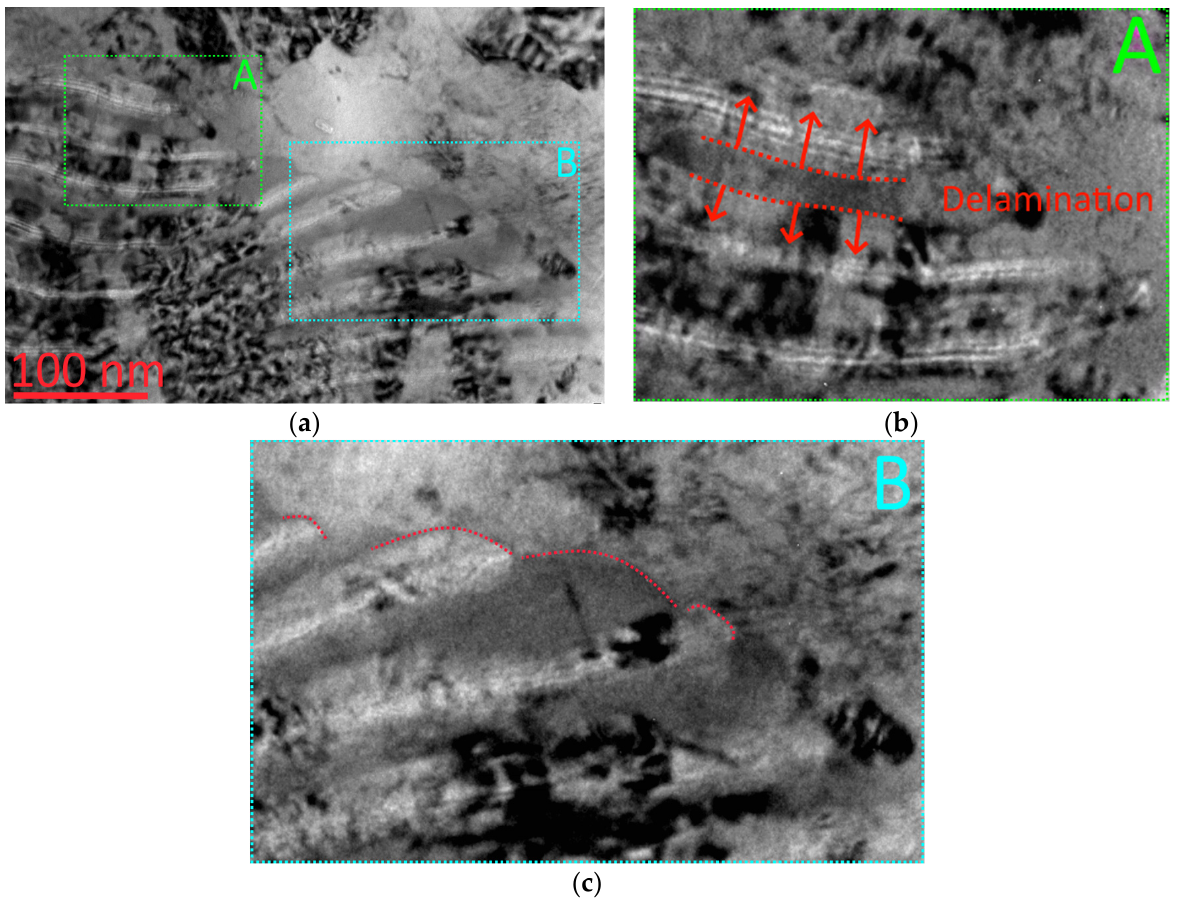
Figure 7. ( a – c ) Effect of the cut material flow on the nanolayer structure of the coating.